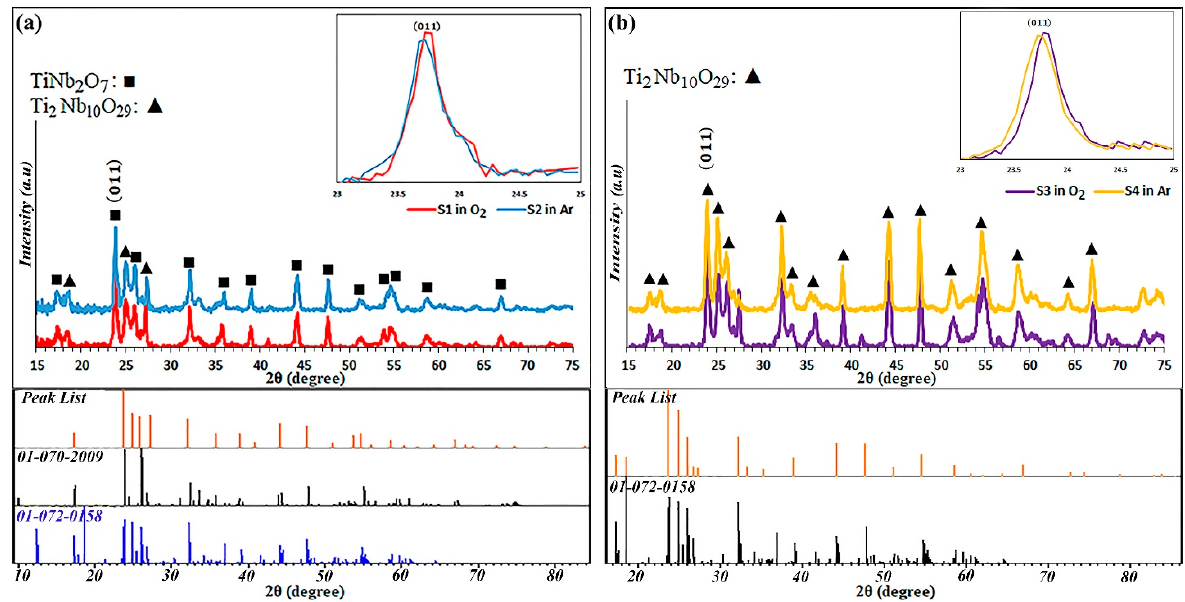
Figure 2. Diffracted X-ray patterns of the TiNb 2 O 7 and Ti 2 Nb 10 O 29 compounds, annealed under different atmospheres ( a ) Peak shift of the (011) plane composition TiNb 2 O 7 and ( b ) Peak shift of the (011) plane composition Ti 2 Nb 10 O 29.